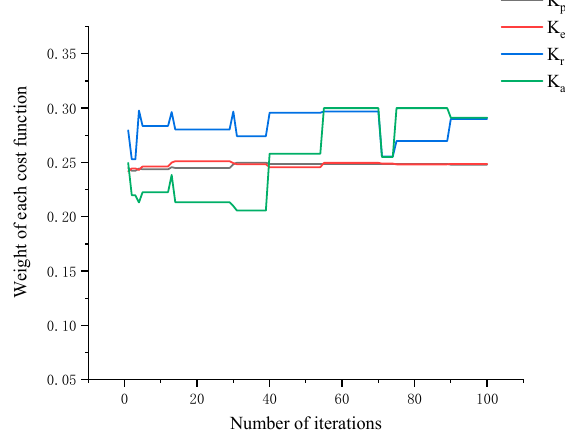
Figure 10. The weight of cost function of EPA-PSO algorithm after 100 iterations.